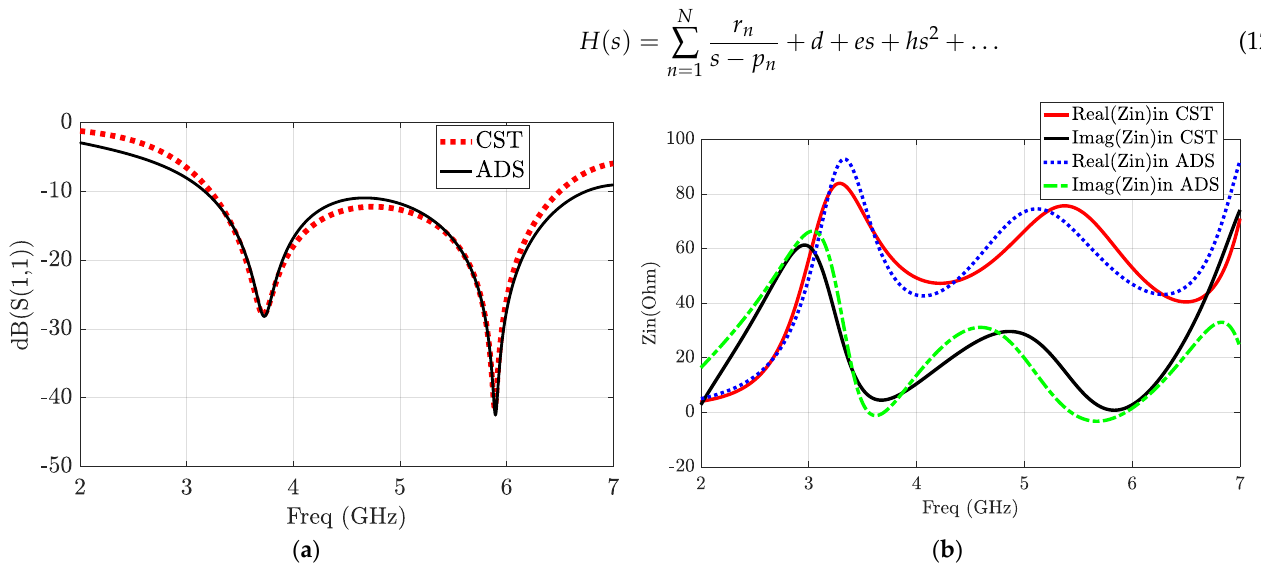
Figure 3. ( a ) Comparison of the SPICE equivalent circuit based on impedance and CST S11 results; ( b ) comparison of the resulting impedance from CST and equivalent circuit.